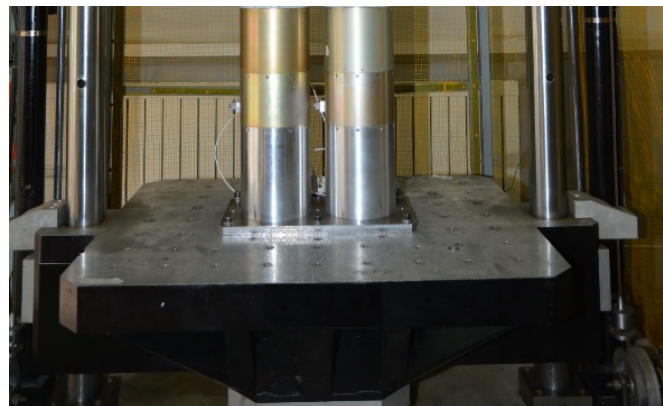
Figure 8. Image of the drop test system.